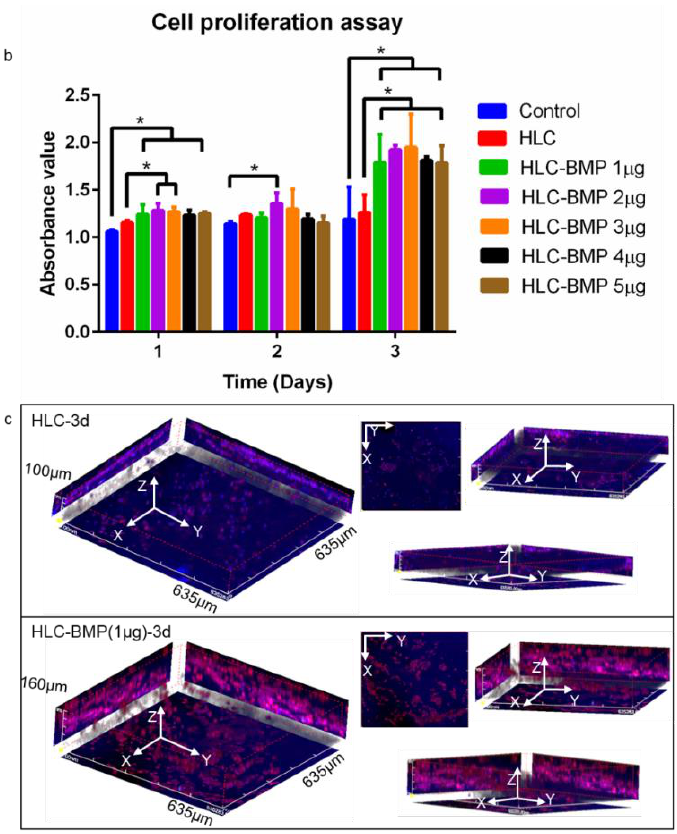
Figure 3. Mesenchymal stem cells (MSCs) attachment and proliferation. ( a ) SEM images of MSCs attached in the HLC and HLC-BMP sponges after culturing for 4 h, respectively. The MSCs in the pores of HLC and HLC-BMP sponges exhibited pseudopodia after only 4 h culture. ( b ) MSCs proliferation on HLC, HLC-BMP (HLC absorbed 1, 2, 3, 4, and 5 µ g BMP-2 dimer, respectively) sponges, and culture plate (control) was investigated by Cell Counting Assay Kit-8, respectively. ( * p < 0.05, n = 4). ( c ) Confocal 3D reconstructions of encapsulated rat MSCs, stained by a β -actin primary antibody, Alexa Fluor ® 594-conjugated donkey anti-rabbit secondary antibody and DAPI, in HLC and HLC-BMP